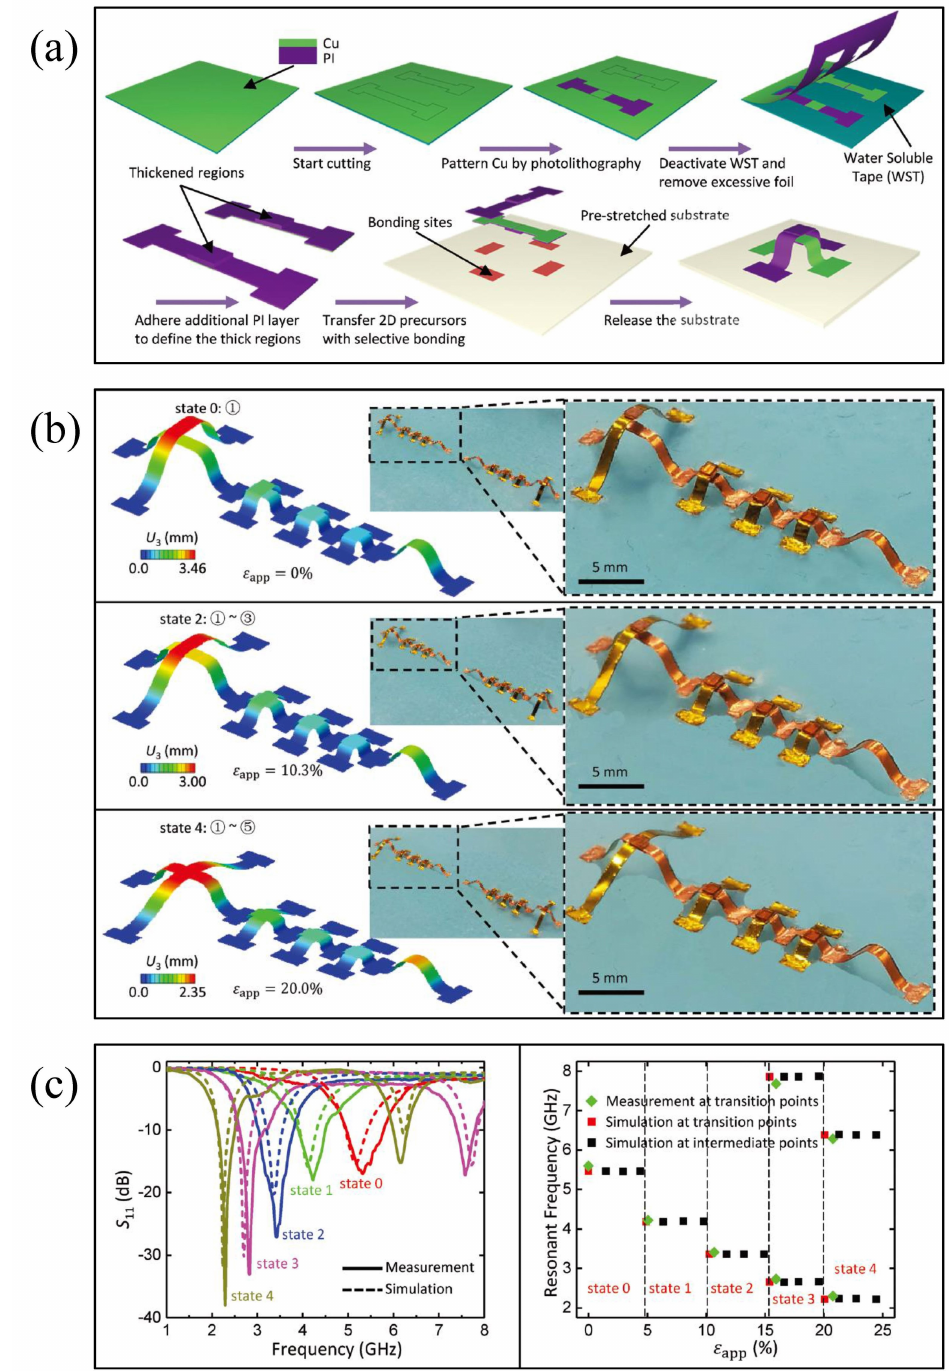
Figure 13. ( a ) Image of the preparation process for the mechanically guided 3D assembly switch [143] Reprinted/adapted with permission from Ref. [143]. 2019, John Wiley and Sons. ( b ) FEM and optical images of the antenna under different tensile states [143] Reprinted/adapted with permission from Ref. [143]. 2019, John Wiley and Sons. ( c ) Measured and simulated characteristics of the antenna at different states [143] Reprinted/adapted with permission from Ref. [143]. 2019, John Wiley and